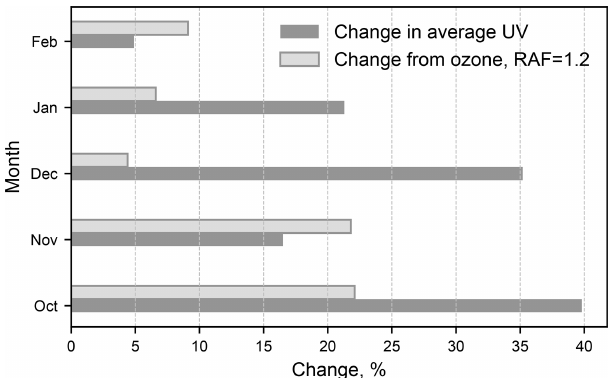
Figure 6. Change in average daily erythemal dose between the sea- sons 2017/2018 to 2018/2019 for each of the months from October to February (dark grey) and expected changes due to decrease in average TOC using RAF = 1 . 2 (light